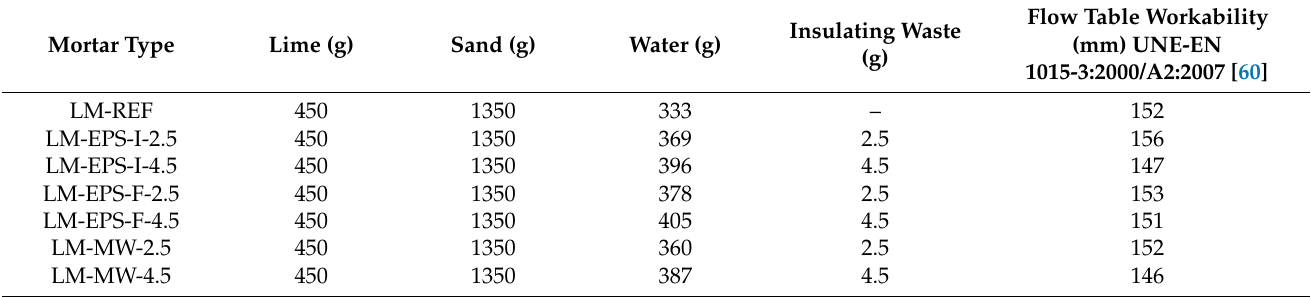
Table 4. Mixtures proportions by weight and workability of the test